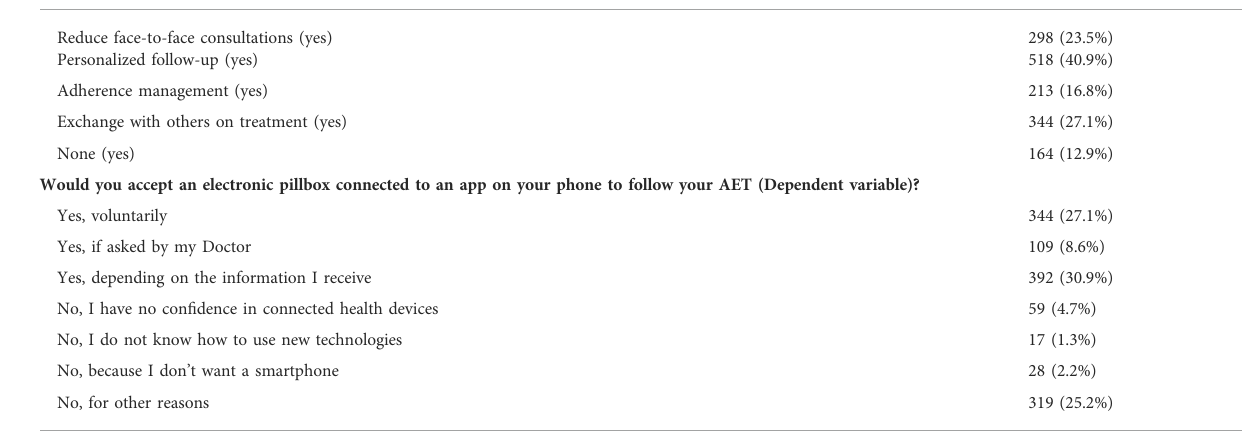
Figure 1 highlights the stepwise multivariable logistic